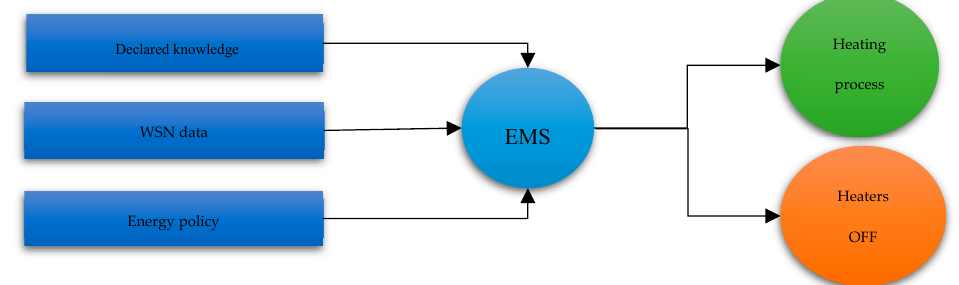
Figure 10. Knowledge types used in enabling and disabling the heating process.